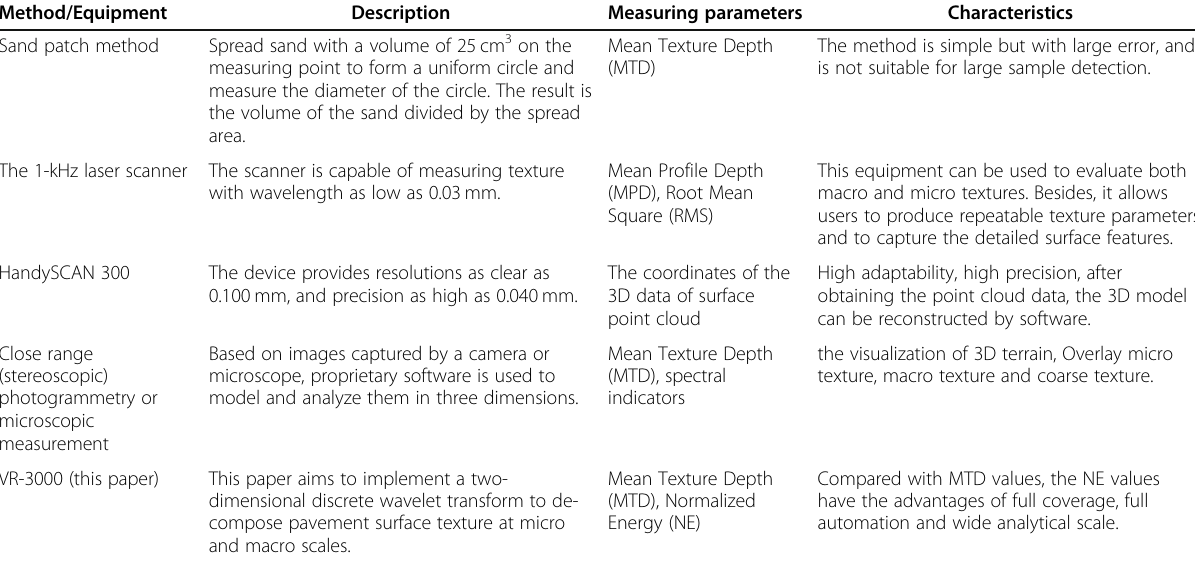
Table 1 Review of pavement texture research